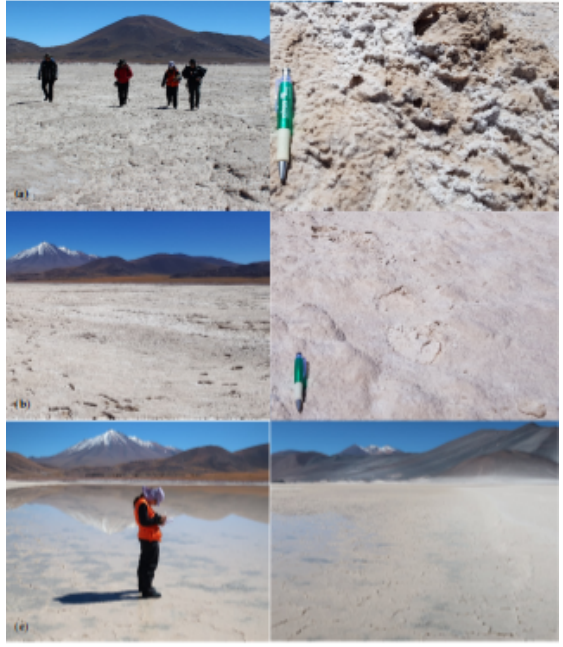
Figure 2. Types of salt crust observed in the field on April 3, 2018. (a) Upper panel: Hard pan crust 1, mixture of salts and sediments (rough surface); (b) Center panel: Hard pan crust 2 (gypsum and halite); (c) Bottom panel: Soft pan crust with Table 1. Monthly rate of increase of VV polarized contents of organic matter and thrust polygons by interaction backscattering coefficient σ 0 during dry periods where with water. roughness variations at millimeter-scale are dominated by increasingly large halite